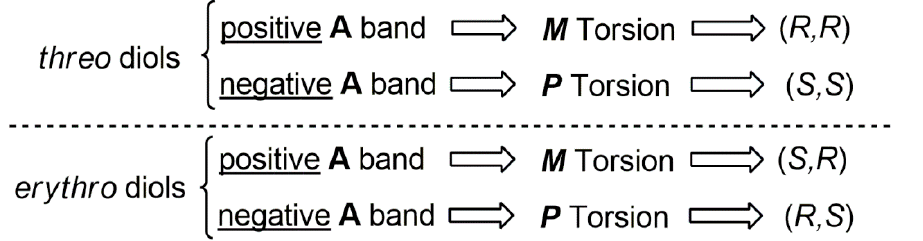
Figure 4. Mnemonic scheme relating the AC of threo and erythro diols with the sign of the A band (at c.a. 250 nm) in the ECD spectrum of their biphenyl dioxolanes.